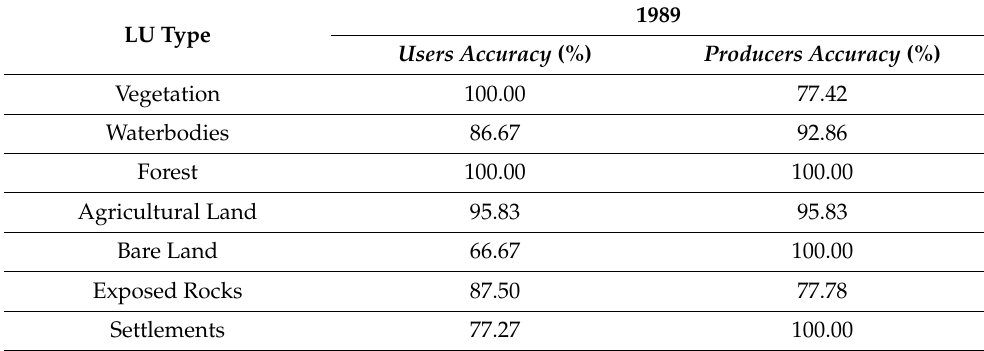
Table A7. User accuracy and overall accuracy for the LU/LC types in 2009.